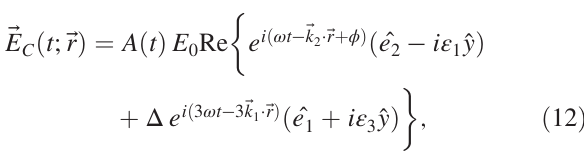
FIG. 4. Dynamical inversion symmetry-breaking-based chirality detection in HHG: Numerical model potential results. (a) Illustration of scheme (C) with the pump field given in Eq. (12). The inset shows the 3D Lissajou plot of the microscopic electric field vector in the focus, which exhibits a dynamical inversion symmetry (arrows along the Lissajou represent the direction of time). (b) High harmonics emitted from the chiral and achiral ensembles ( ψ 15 in the model potential), fundamental wavelength λ ¼ 700 nm, I 0 . 4 , ε 0 . 3 , α ¼ 20 0 , and a trapezoidal envelope with four-cycle turn-on/off and five-cycle flattop. (c) Chiral/ ϕ ¼ π = 2 , Δ ¼ 1 , ε 1 ¼ 3 ¼ achiral signal from y -polarized even harmonics as a function of α for the same conditions as in panel (b). The dashed line represents an approximately ∼ sin ð 2 α Þ trend line for the harmonic yield, roughly representing the increase of the chiral signal with α